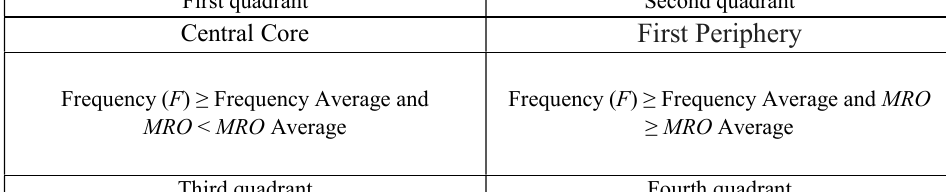
Table 2: Structure of the four-house chart, resulting from the prototypical analysis. First